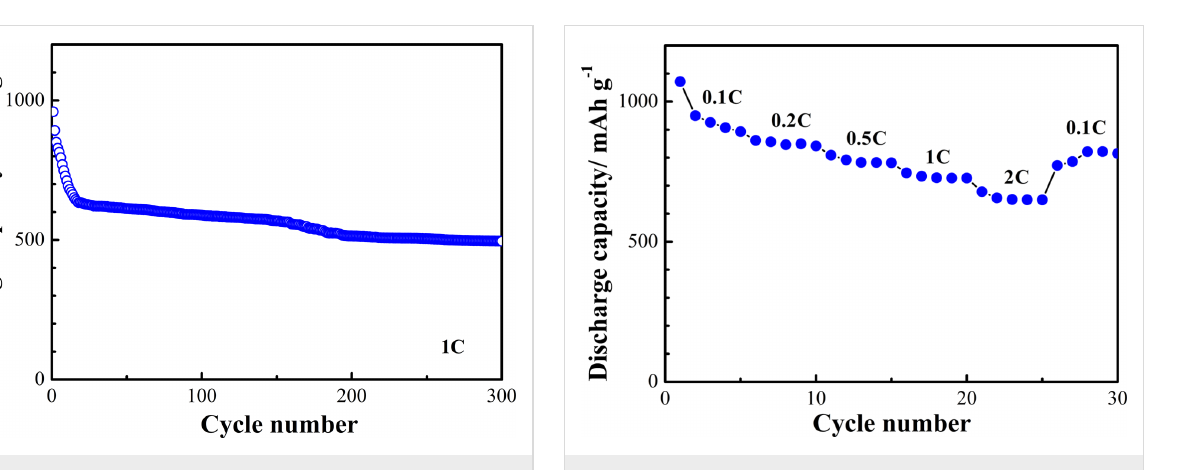
Figure 8: Long-term cycle life of the S/ZnO@NCNT cathode at 1C.